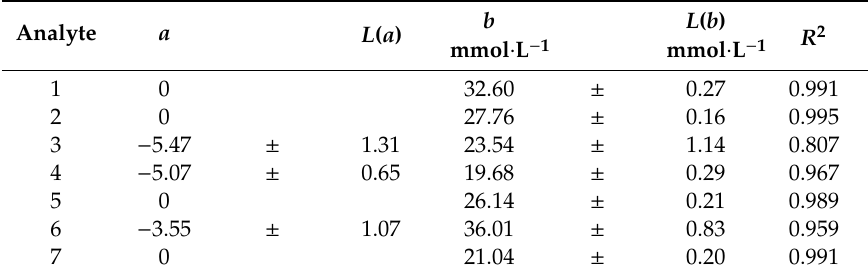
Table 1. Calibration dependences of separation of analytes 1–7 (Figure 2) measured under optimal conditions, where ( a ± L ( a )) is the intercept and ( b ± L ( b )) is the slope with a confidence interval at the significance level α = 0.05; R 2 is the coe ffi cient of determination.